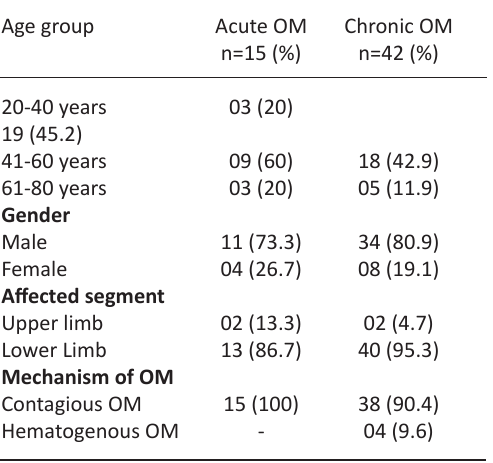
Table 1. Demographic & Clinical